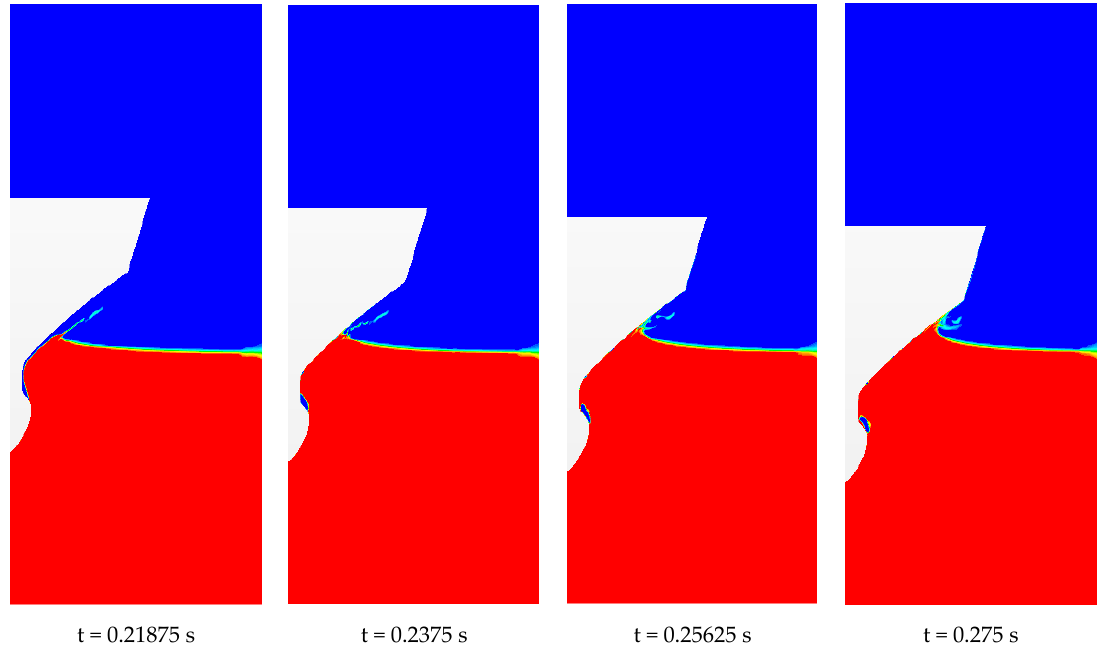
Figure 12. Free surface evolution during the water entry of the modified section “S1”.